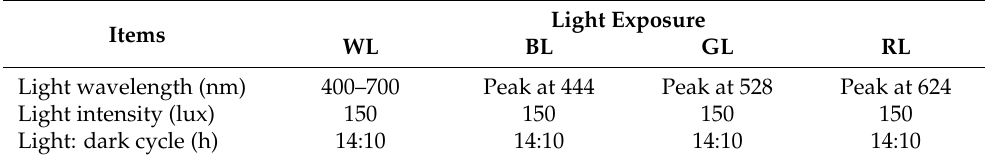
Table 1. Light parameters.